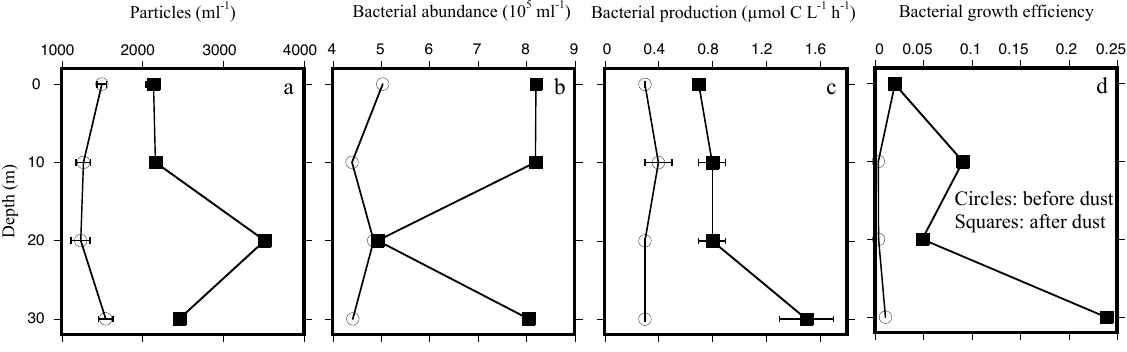
Fig. 6. Comparison of data collected several days after the Sahara dust event (20–21 February, 2004) with data collected the month before. (a) particles, (b) bacterial abundance, (c) production and (d) growth efficiency.